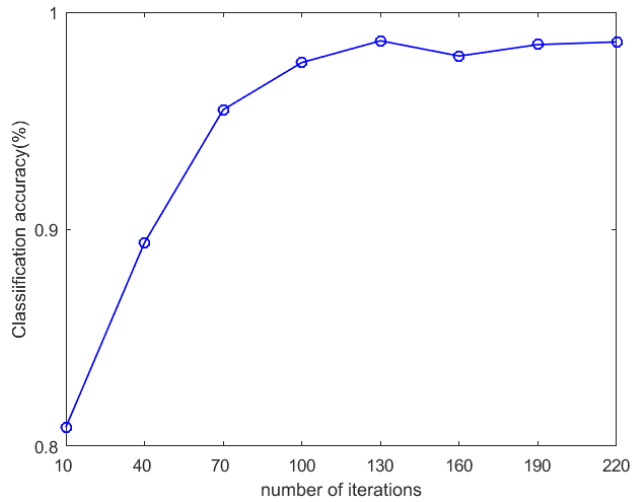
Figure 5. The effect of the number of iterations on the classification accuracy.